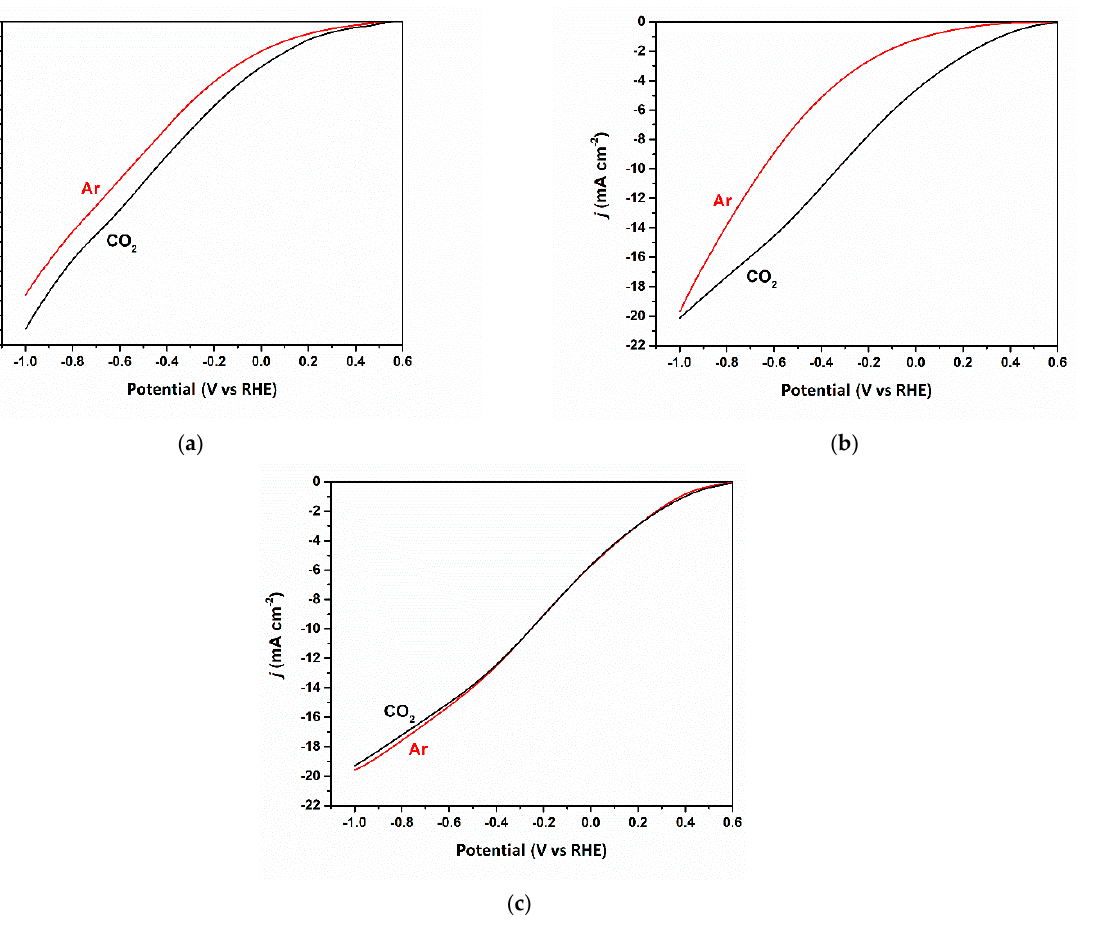
Figure 7. ( a – c ) LSV scans under Ar and CO 2 saturated electrolytes for Cu/Cu x O-PCC-0h, Cu/Cu x O- PCC-1h, and Cu/Cu x O-PCC-6h, respectively.